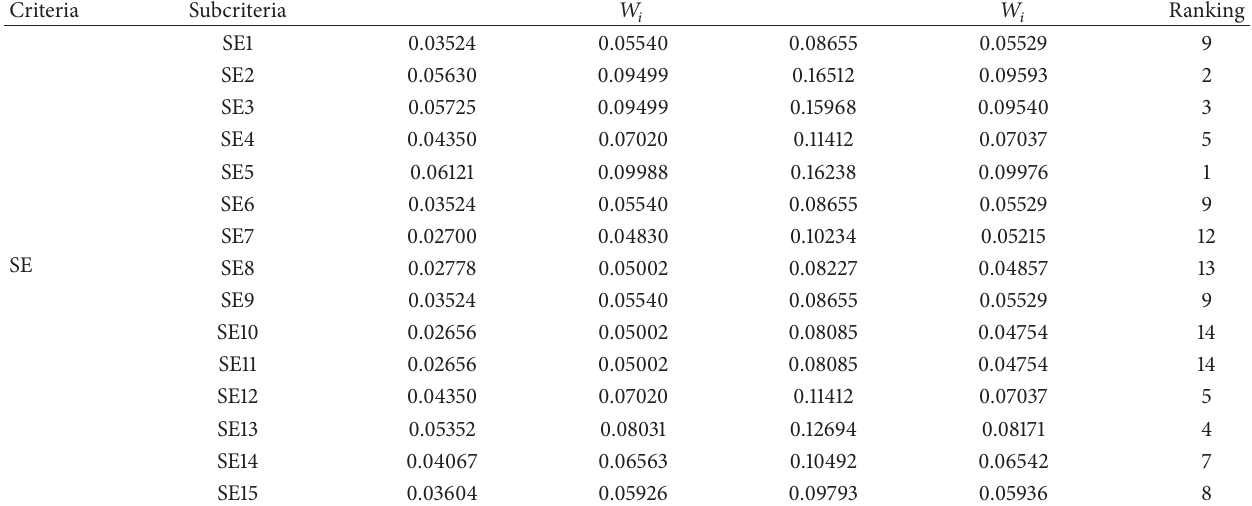
Table 12: Fuzzy and crisp weights and ranking scores for subcriteria in social and environmental group.